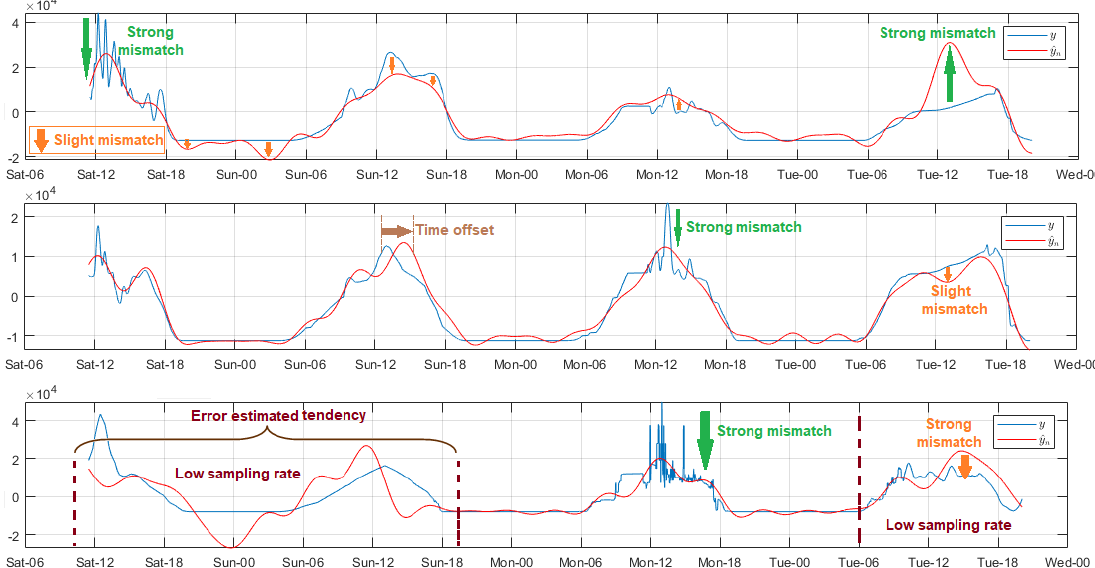
Figure 5. Representative modeled signals of luminosity. From top to bottom: Node 1 of DigiMesh network with Reg = 4, Node 2 of ZigBee network with Reg = 100, and Node 1 of WiFi network with Reg = 50.